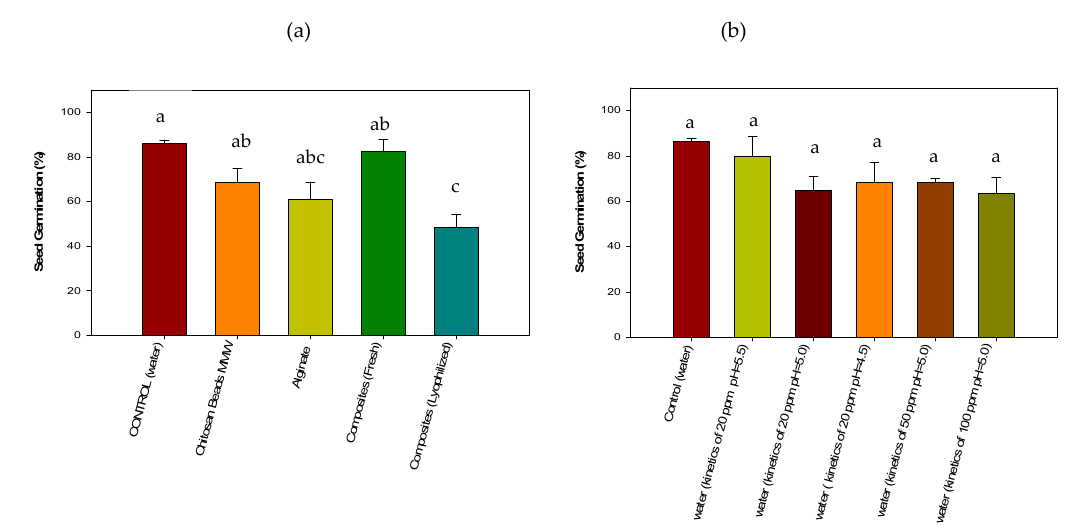
Figure 7. Evaluation of the toxicity of composite beads ( a ) and simulated wastewater after the copper removal treatment ( b ) on the germination of Lactuca sativa seeds.